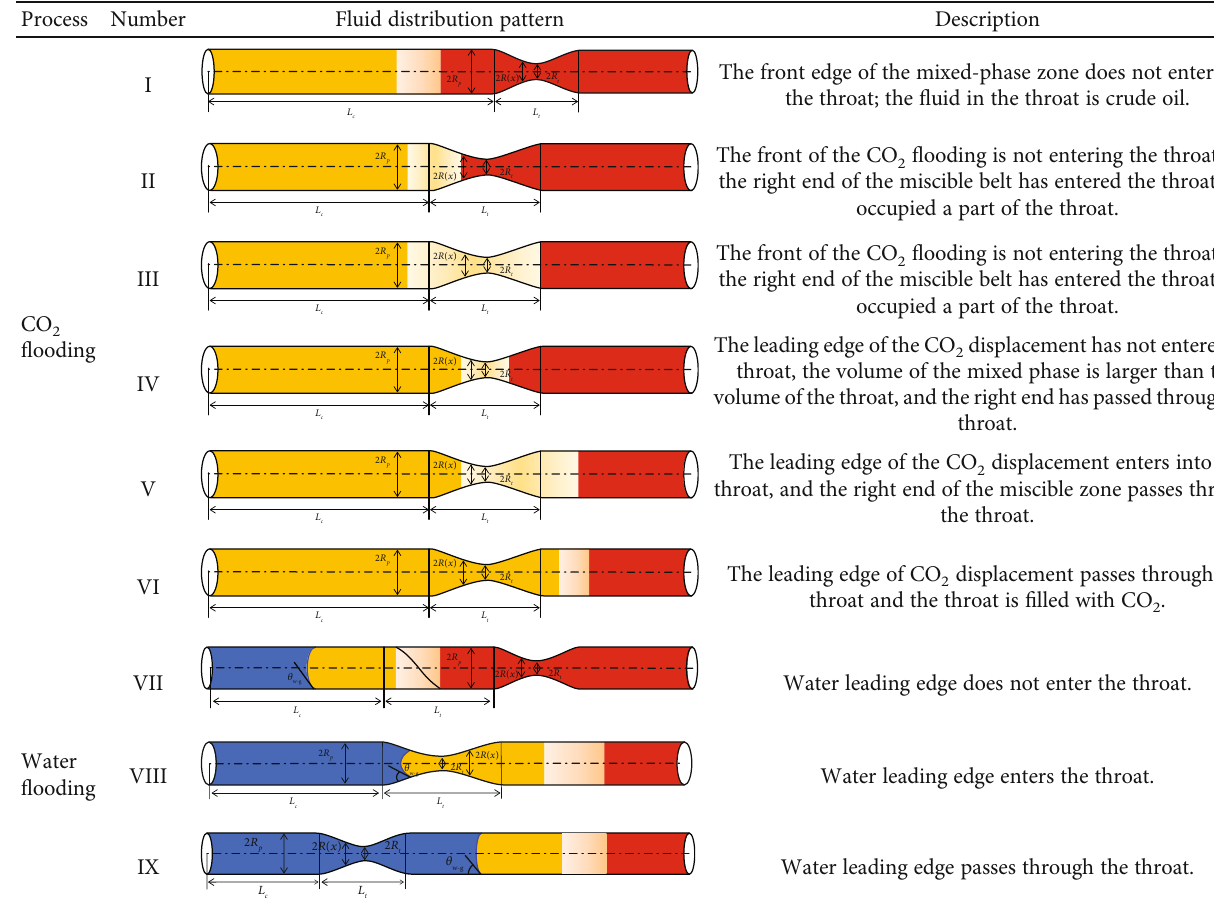
and water fl ooding. 2